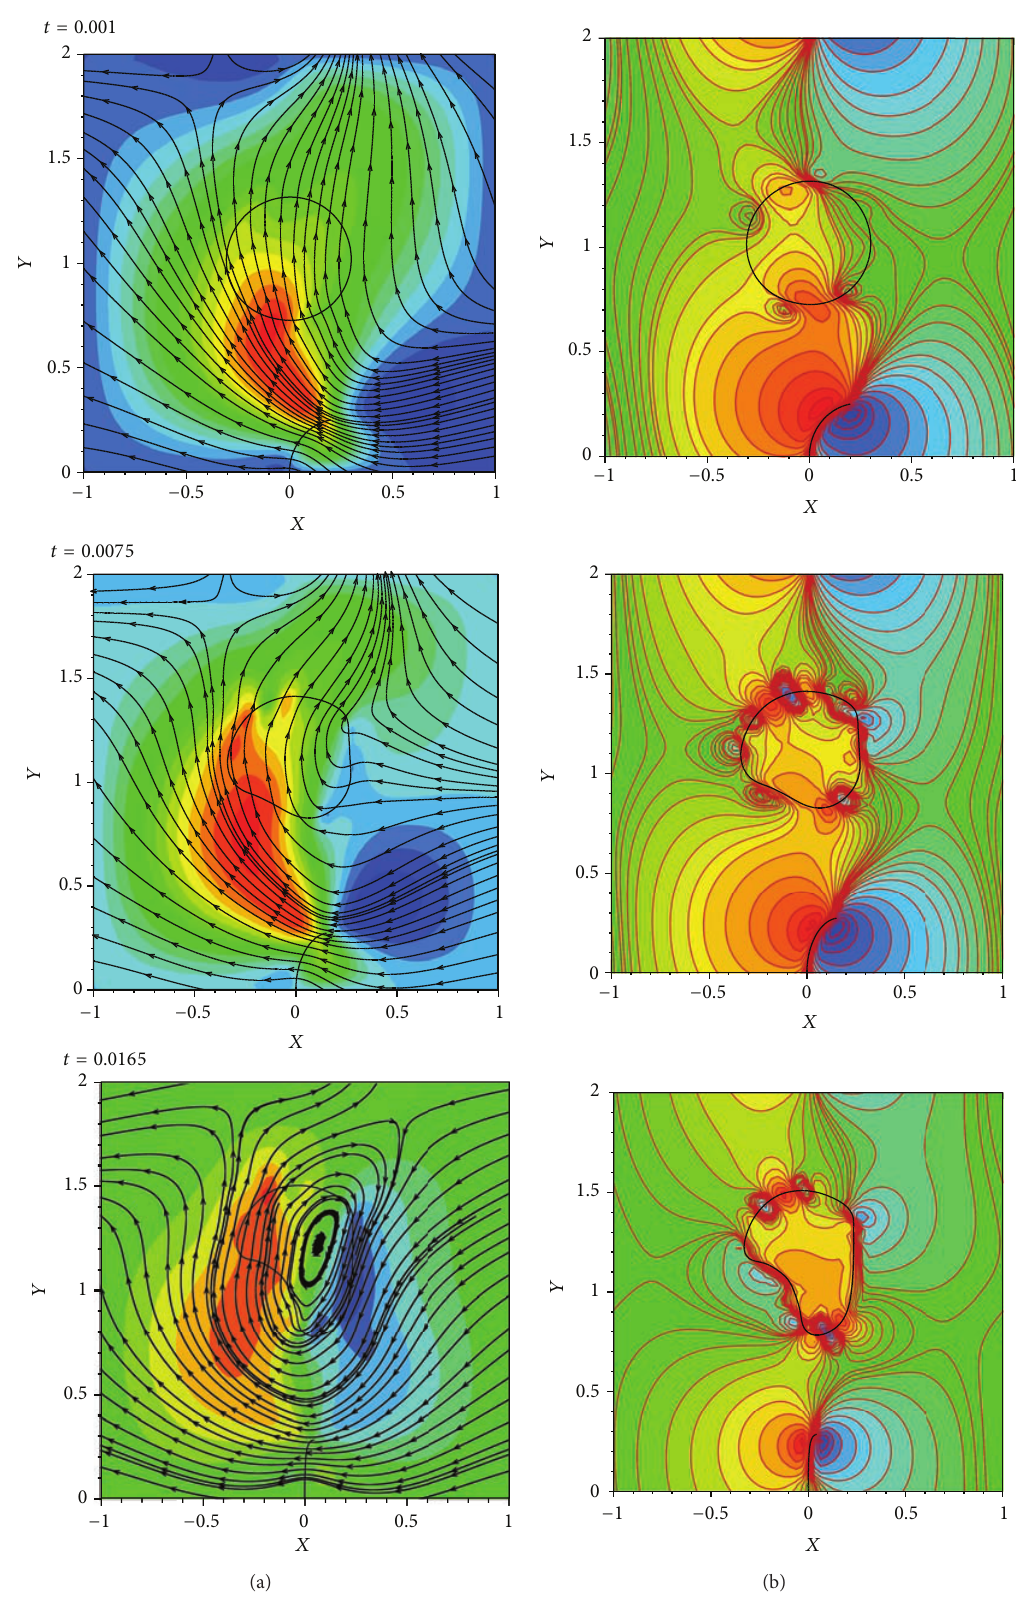
Figure 13: Contours of 𝑥 -component velocity along with streamlines (a) and contours of pressure (b) at times 0.001, 0.0075, and